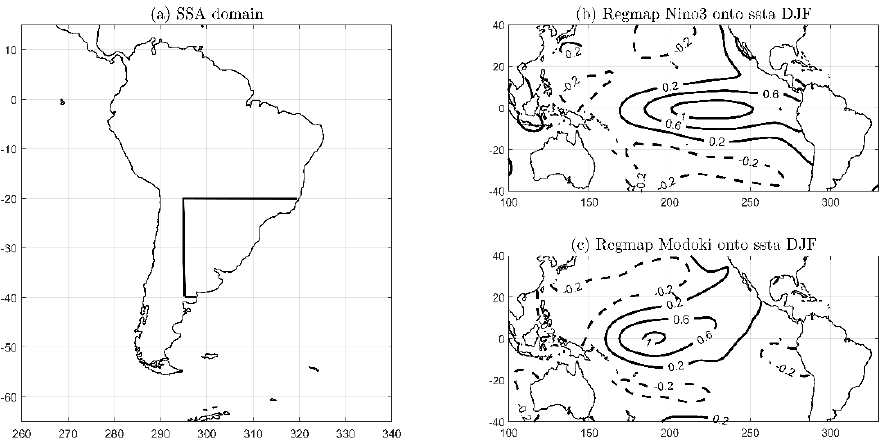
Figure 1. ( a ) Subtropical South America (SSA) domain; ( b ) regression map of Niño3 index onto sea surface temperature (SST) anomalies over the period (1979–2016); ( c ) regression map of El Niño Modoki index onto SST anomalies over the period (1979–2016). Both indices and anomalies are centered on December-January-February (DJF).